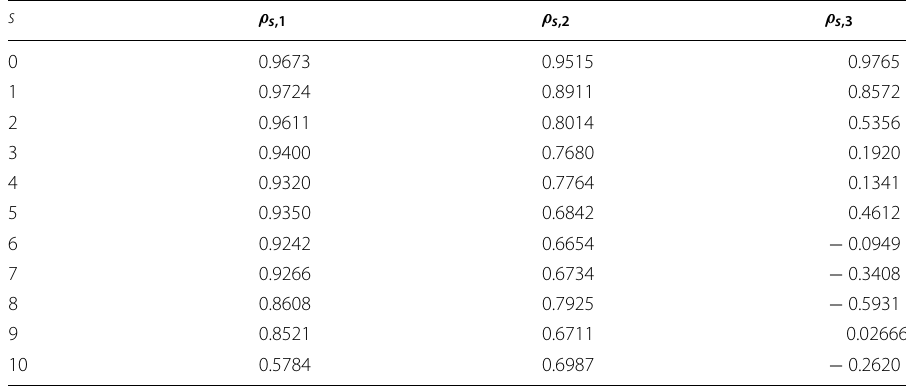
Table 4 Correlation between the incurred claims and paid losses in the same LOB